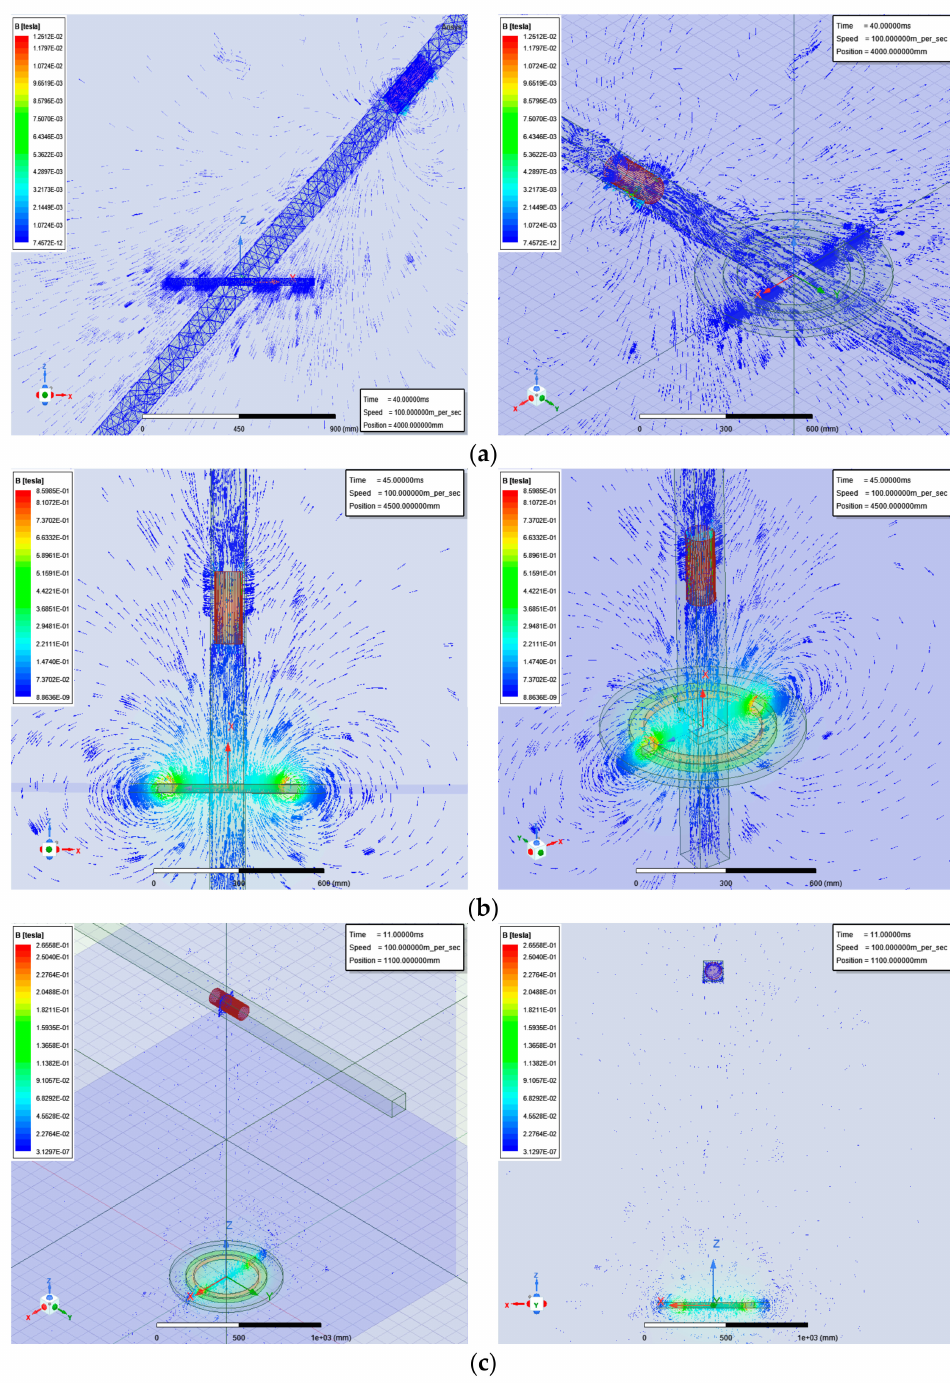
Figure 8. Simulation of eddy currents at different incidence angles. ( a ) 45 ◦ ; ( b ) 90 ◦ ; ( c ) 0 ◦